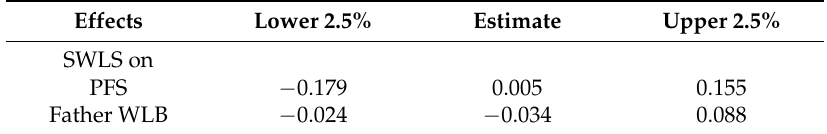
Table 6. Confidence intervals in the model that includes the fathers’ work-life balance (Father